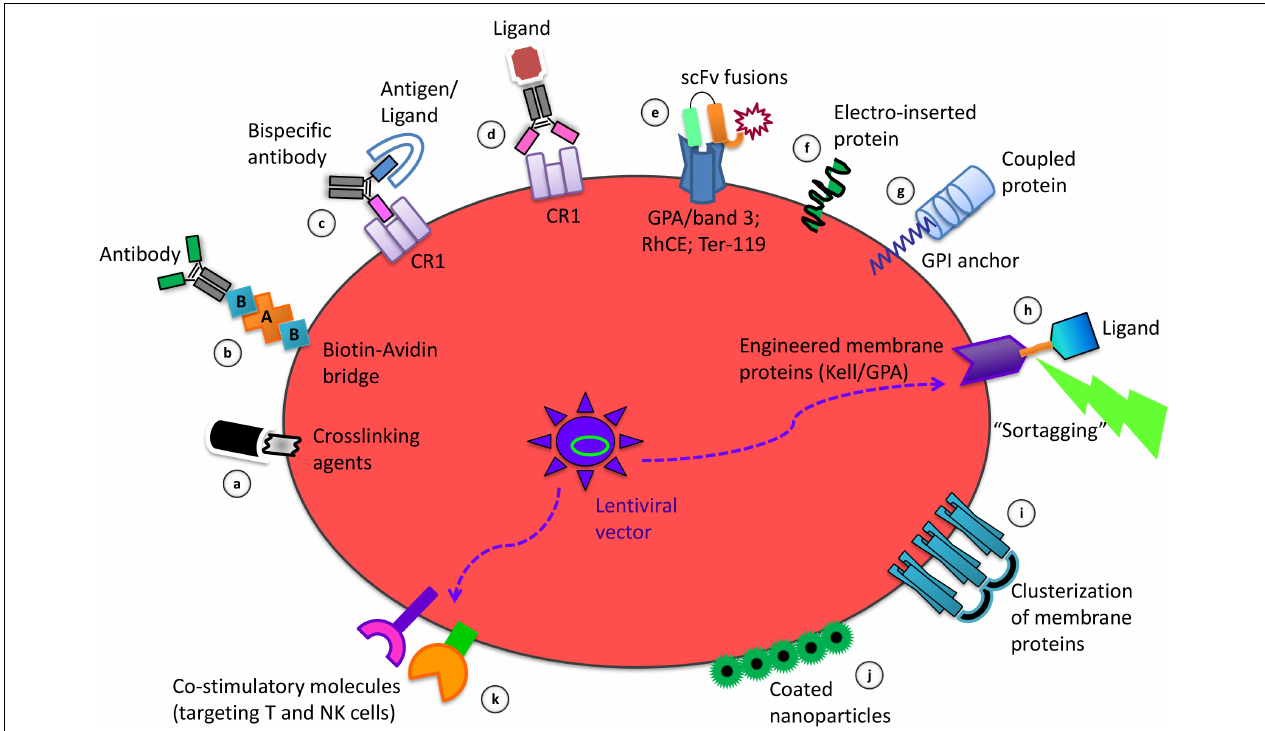
FIGURE 1 | Strategies of RBC membrane processing to obtain the delivery and targeting of therapeutic agents and to induce immune tolerance or immunogenicity. Among the coupling modalities for binding of molecules to the RBC surface there are: the use of crosslinking agents for chemical coupling of ligands (a) ; the biotinylation to couple selected antibodies by an avidin bridge (b) ; the use of bispecific antibodies targeting antigens/ligands to the RBC specific protein target CR1 (c) ; the crosslinking of antibodies carrying a specific ligand to Complement Receptor 1 (CR1) (d) ; the use of scFv-based fusion constructs targeting GPA/band 3, RhCE, Ter-119, on the RBC surface (e) ; the electro-insertion of transmembrane proteins into the RBC membrane (f) ; the coupling of proteins using the GPI lipid anchor (g) ; the Sortase A-mediated tagging (“sortagging”) of molecules to genetically engineered membrane proteins, expressed upon ex vivo transfection of erythroid precursors with lentiviral vectors, followed by their differentiation into enucleated RBC (h) ; the clusterization of RBC membrane proteins for selective targeting (i) ; the non-covalent attachment of coated nanoparticles to the RBC surface (j) ; the lentivirus-driven co-expression of combinations of co-stimulatory molecules on engineered RBC (k)